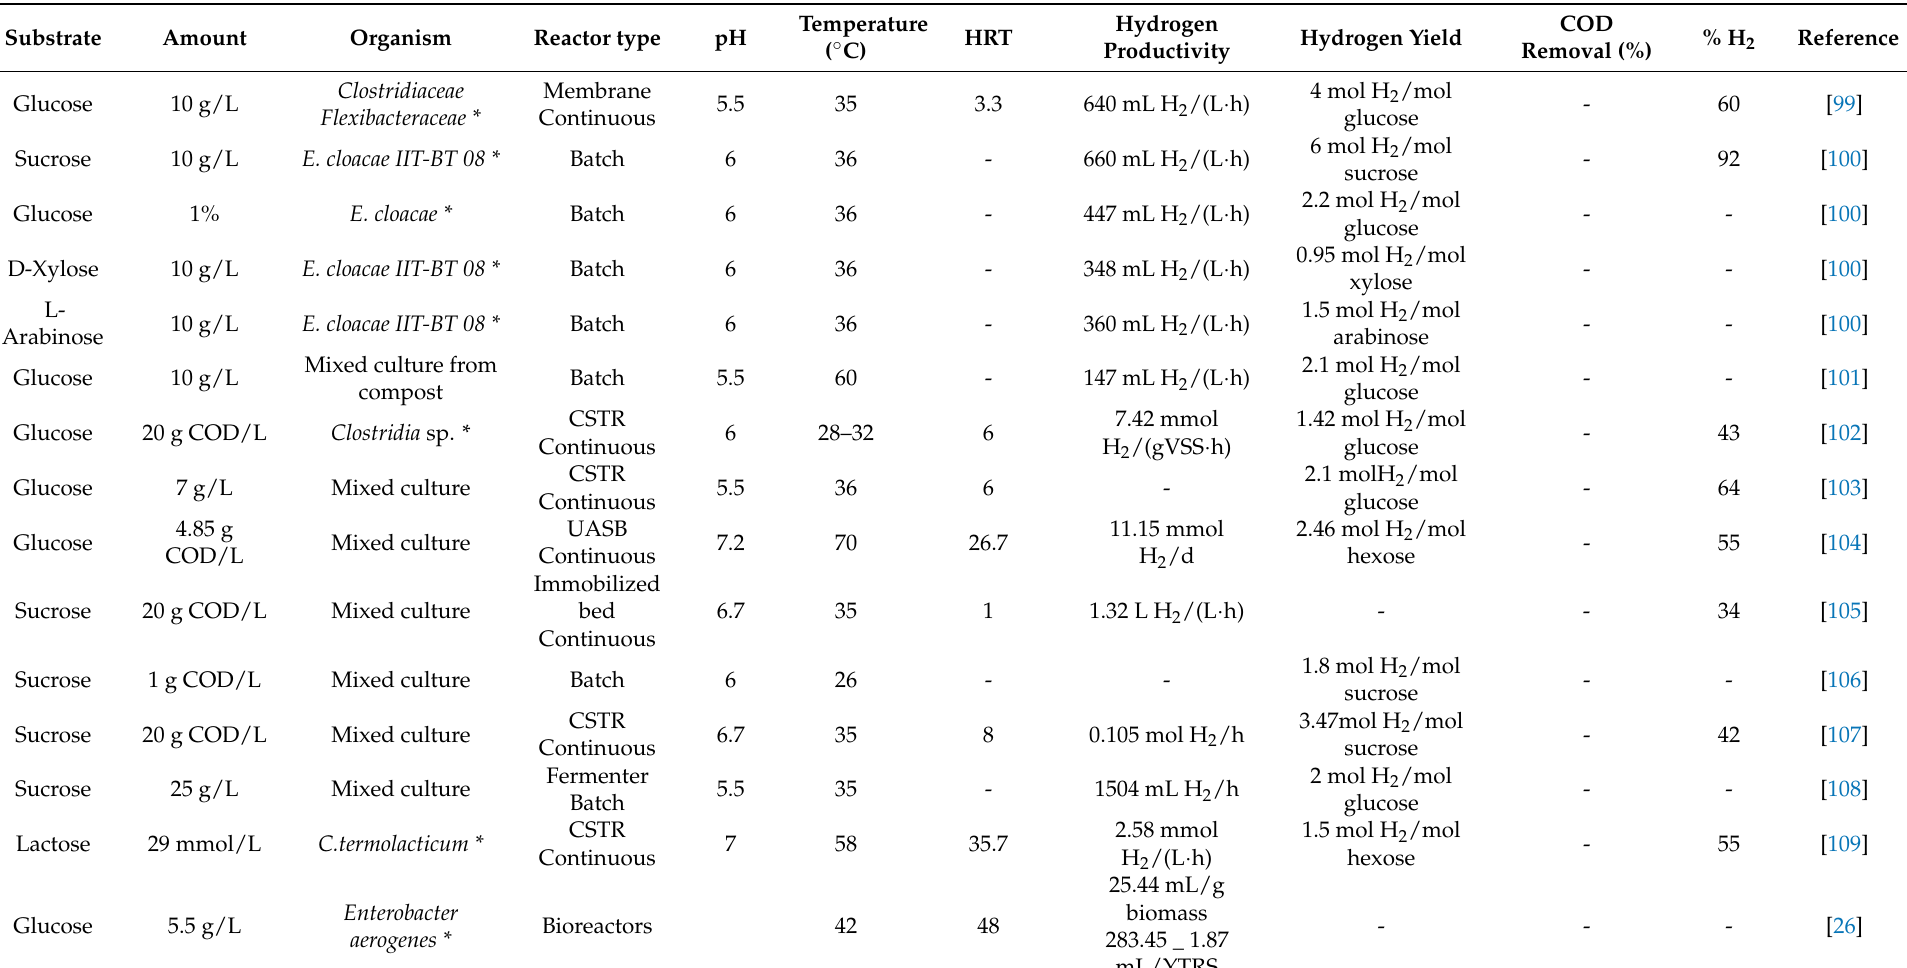
Table 3. The efficiency of bioconversion of biomass hydrolysates concerning applied microorganisms and the main sole carbon source present in the fermentation